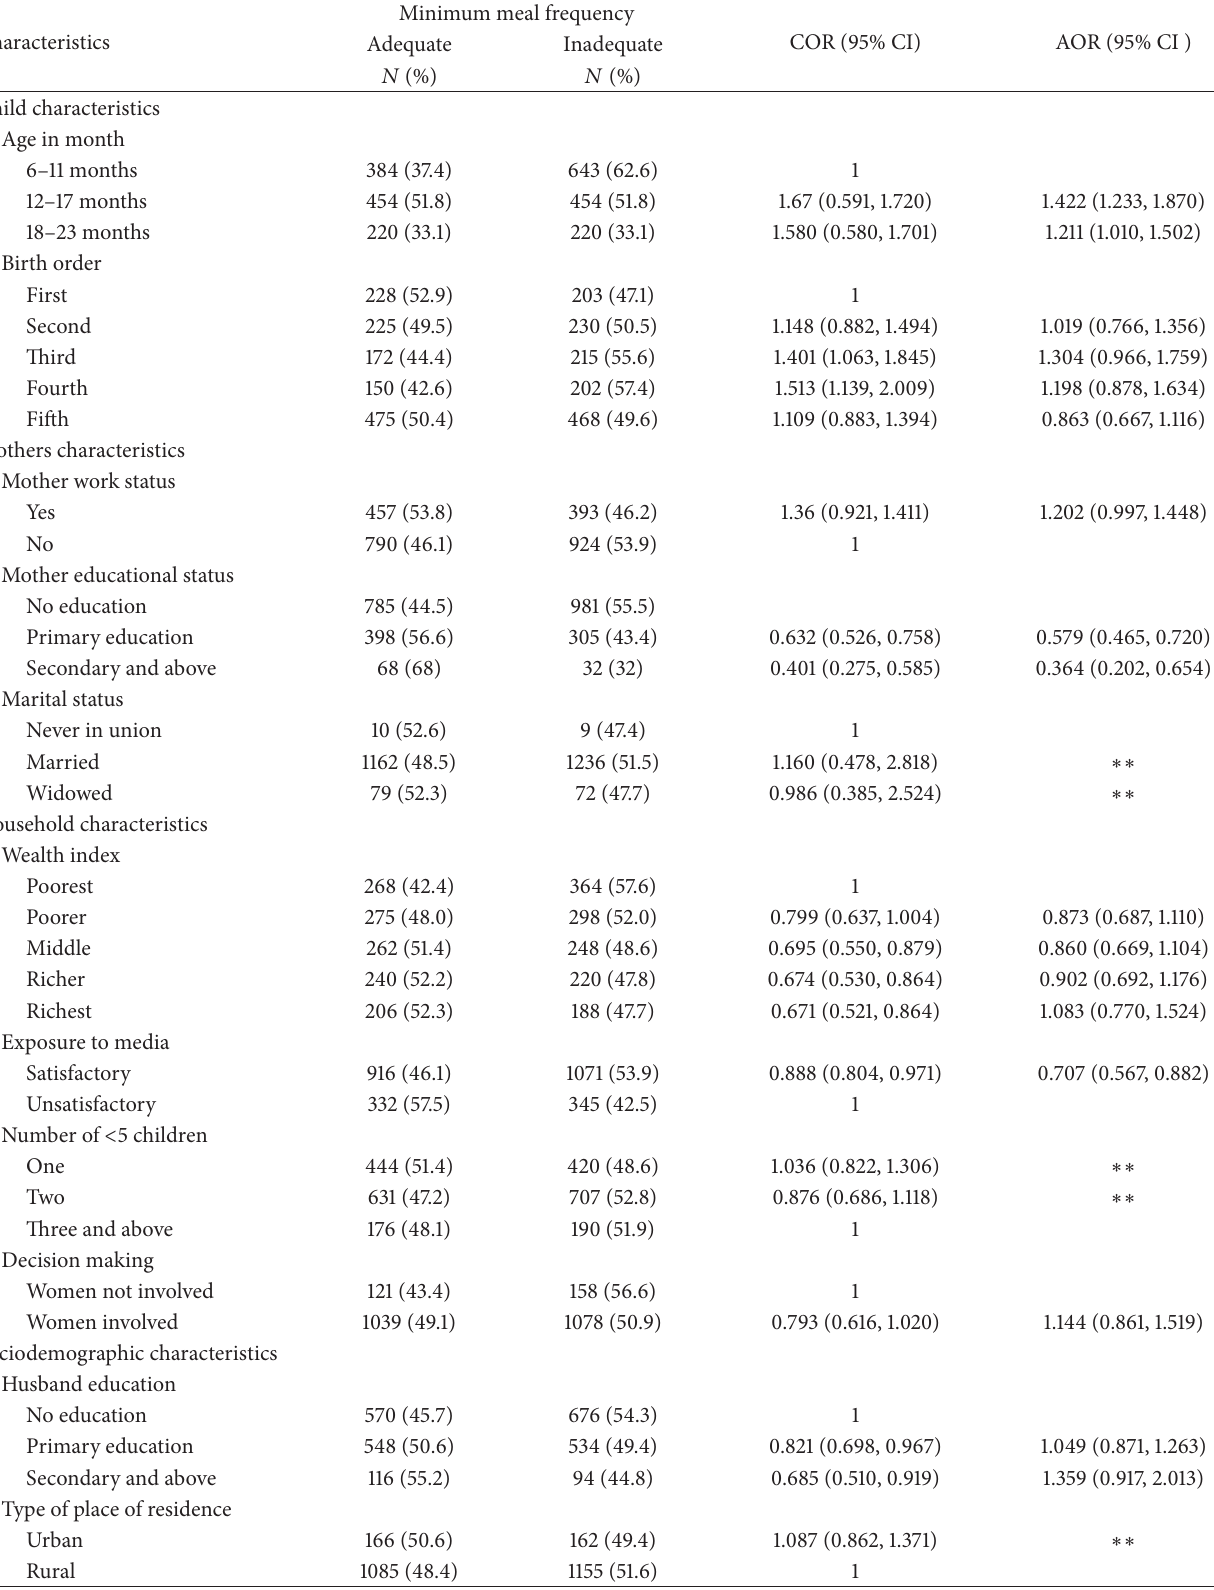
Table 3: Factors associated with minimum meal frequency practice, 2012,